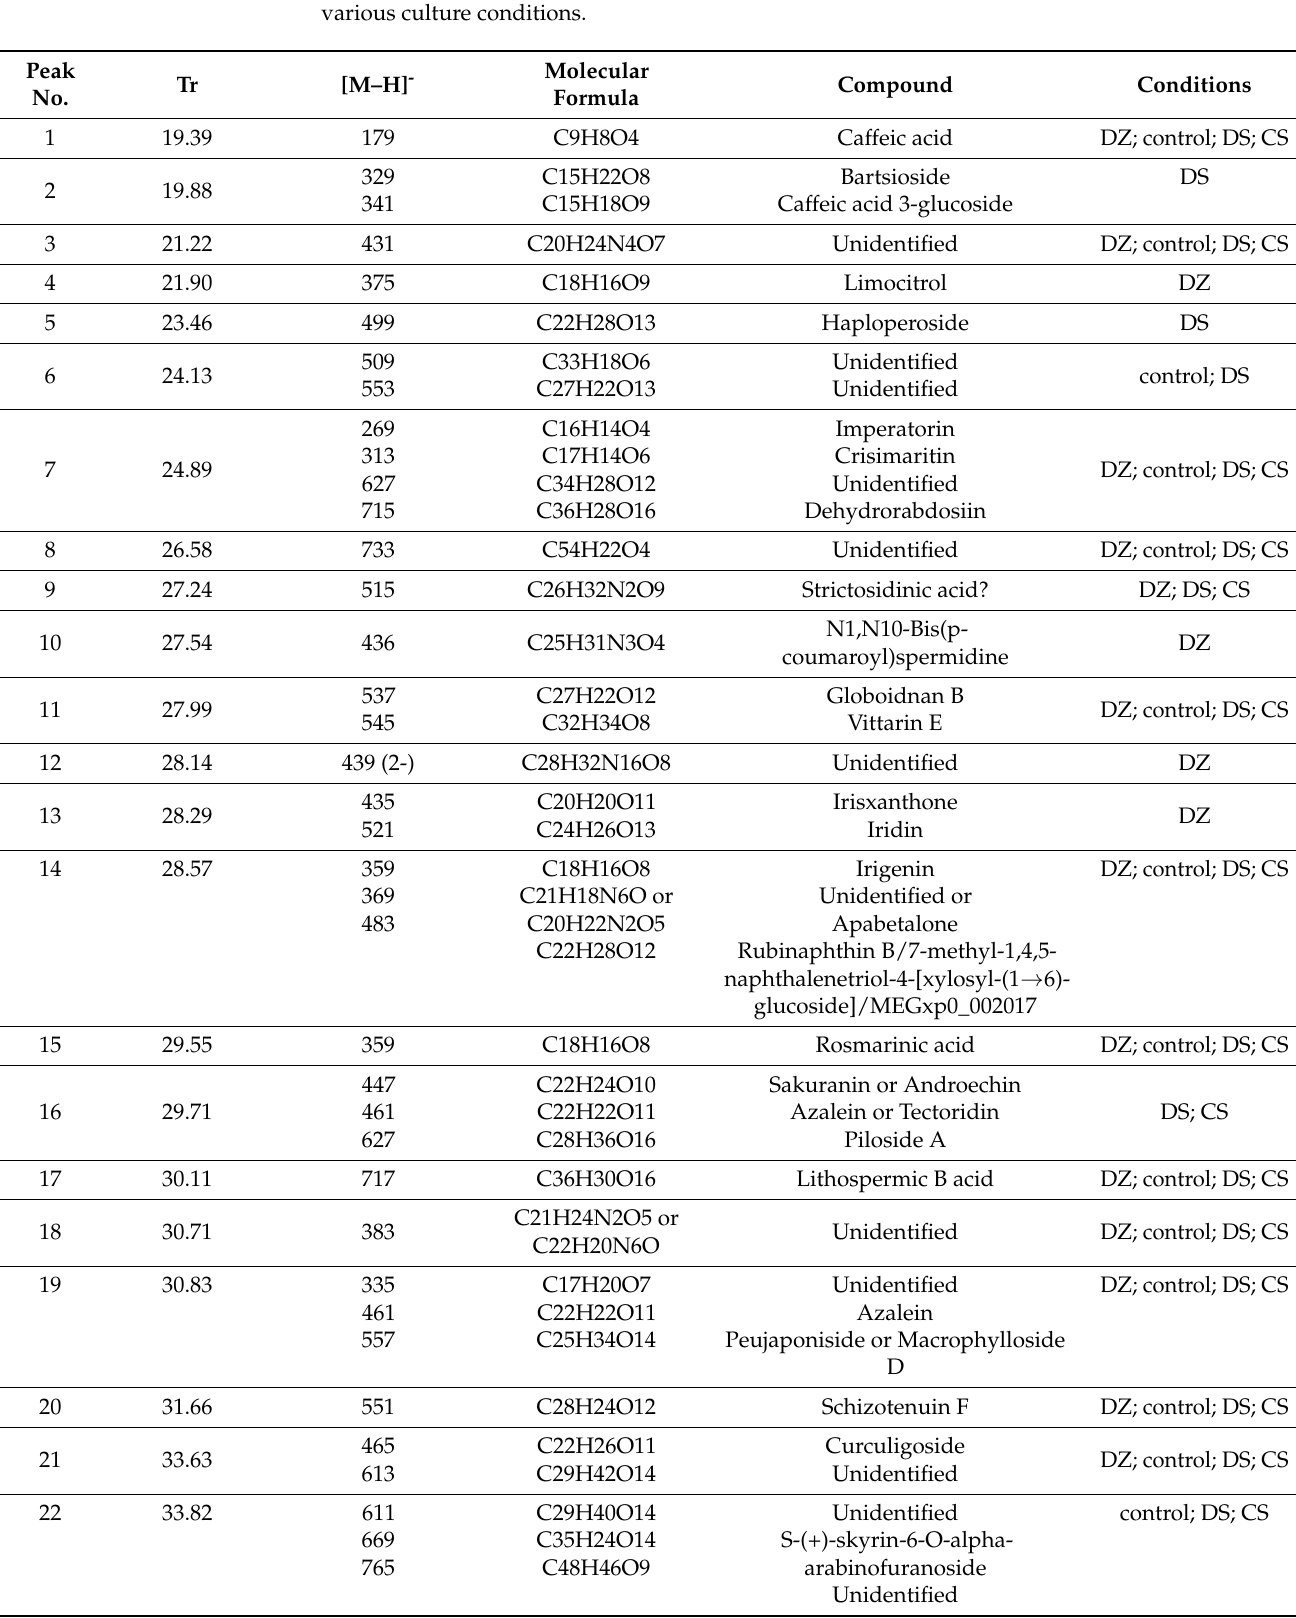
Table 5. HPLC-PDA-ESI-HRMS data on detected compounds in RgAR root extracts derived from various culture